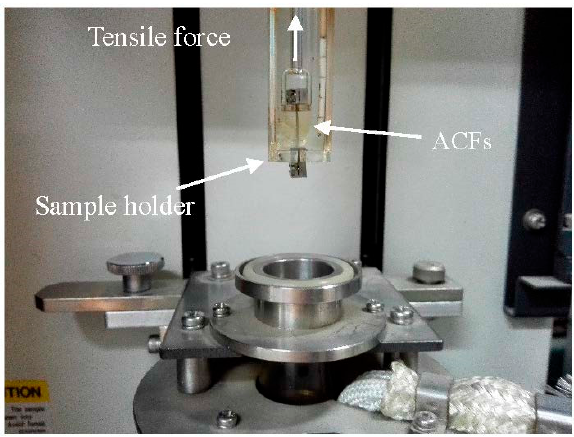
Figure 12. DMA thermo-mechanical property measurement for cured ACFs [9].